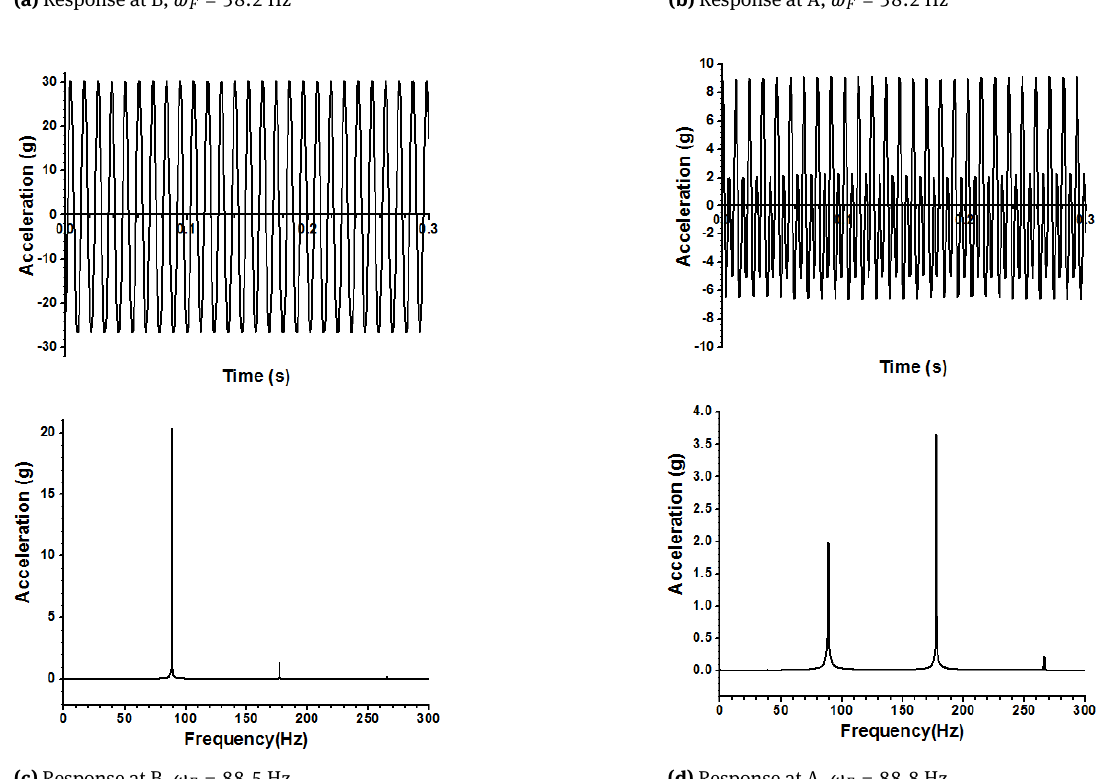
Figure 6: Steady state response history and frequency spectra of curved beam of span angle 80 ∘ excited at location B (excitation amplitude = 3.0